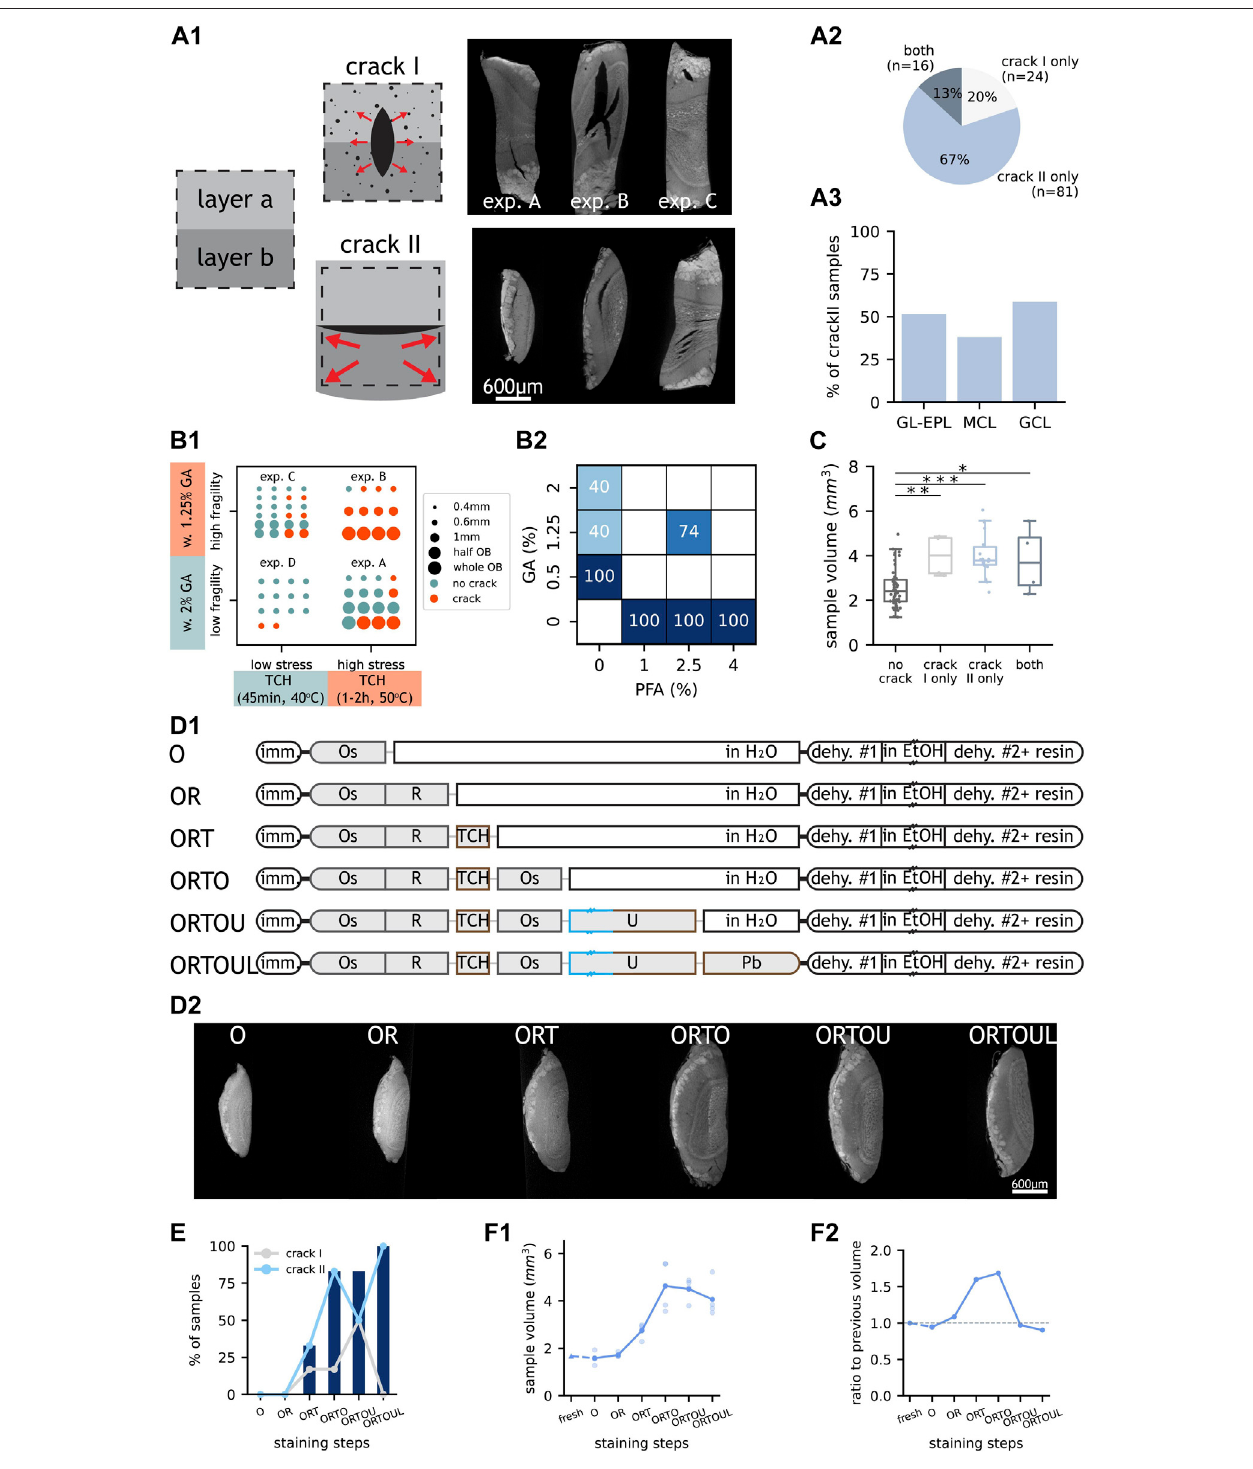
FIGURE 3 | Occurrence and proposed mechanisms of “ crack ” subtypes. (A1) LXRT images of samples with “ crack ” subtypes and schematics of their hypothesised causes. In schematics, “ layer a ” and “ layer b ” represent two tissue layers and the dashed box represents the starting tissue volume i.e., when fresh. Dots represent gas bubbles. Arrows represent expansive forces experienced by the tissue. Top, 0.6 mm-thick representative samples from experiments A, B and C referred to in (B1) . Bottom, samples showing “ crack II ” at GL-EPL boundary, MCL, and GCL, respectively. (A2) Number and percentage of “ crack ” samples with only